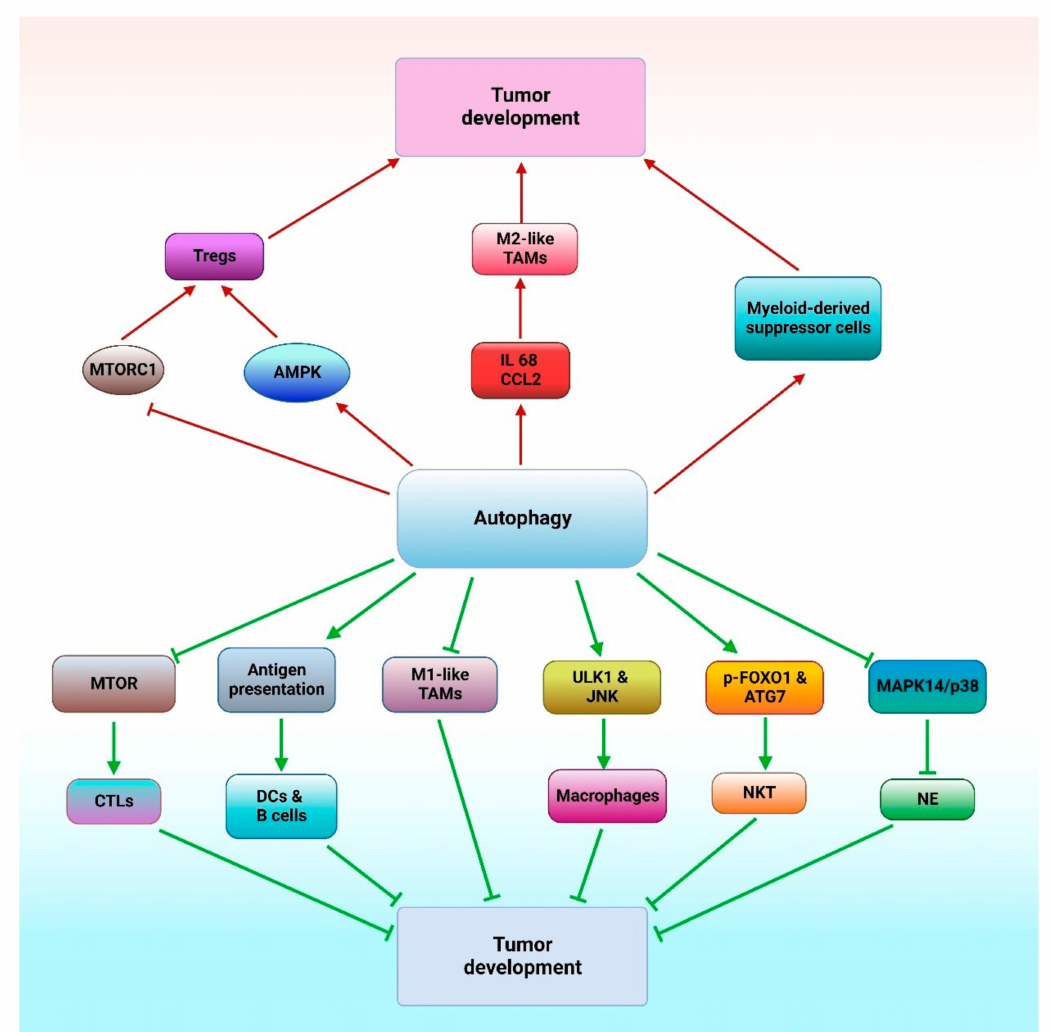
Figure 5. The relationship between autophagy and immune cells. Autophagy activation can increase or prevent tumor development by modulating the immune system. Autophagy inhibits tumor development through MTOR inhibition, antigen presentation, M1-like TAM polarization, ULK1 and MAPK/JNK activation, phosphorylation of FOXO1 working with ATG7 and inhibition of MAPK14/p38. Autophagy can promote tumor development by M2-like TAMs, regulatory T cells (Tregs) and myeloid-derived suppressor cells. The figure was created with BioRender.com. Licensing Right RN24OB6GKQ, 21 November